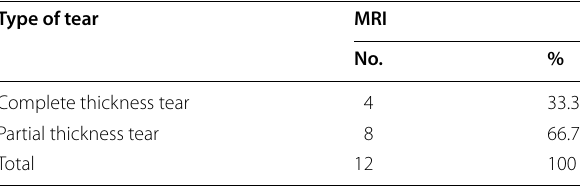
Table 4 MRI results in detecting thickness of flexor tendon tear in patients with history of